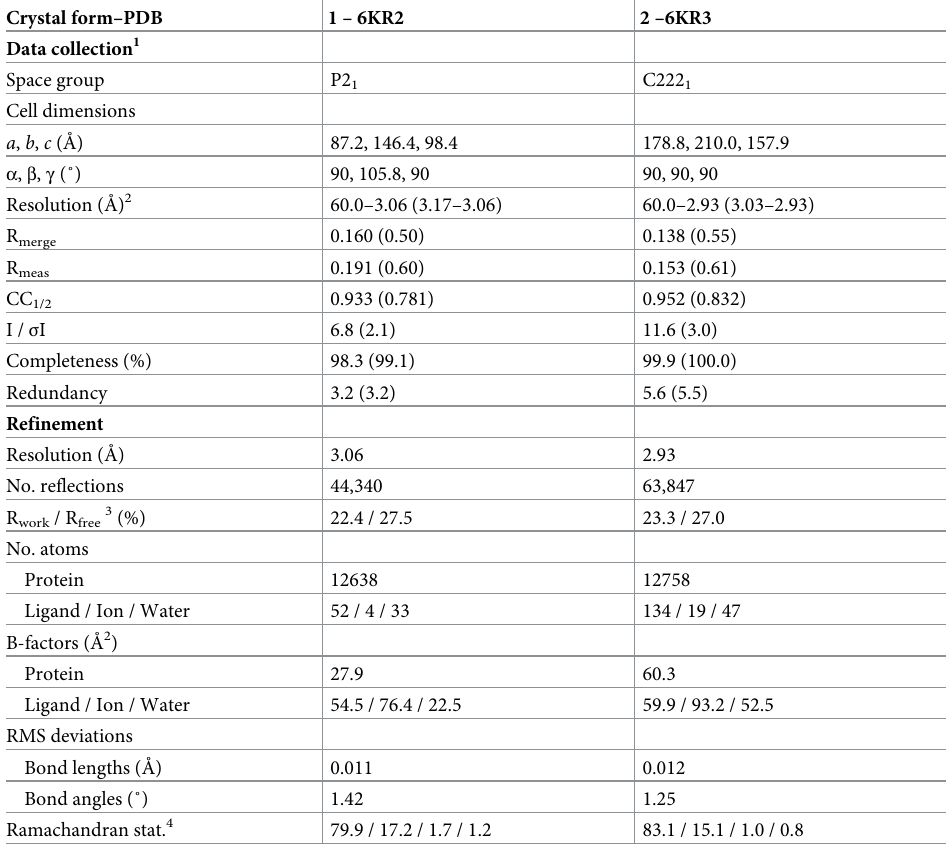
Table 1. X-ray diffraction data collection and structure refinement